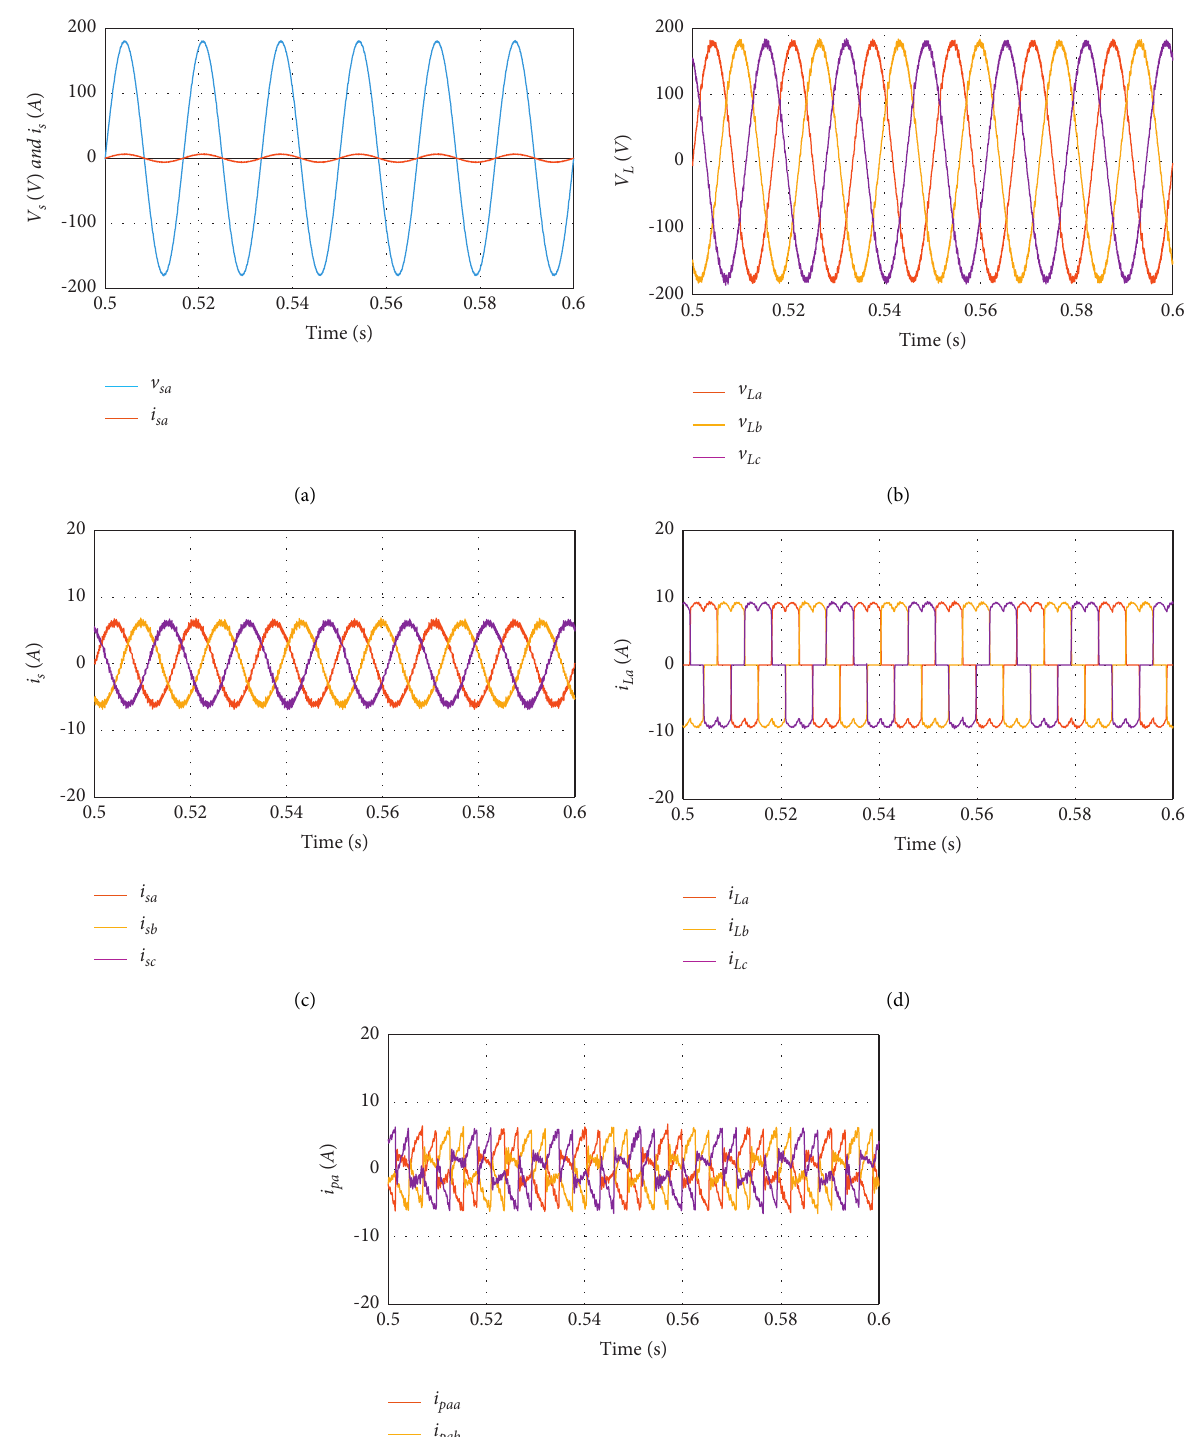
Figure 6: Active filtering along with active power interjection is performed by Wind-PV-UPQC with P current, (b) load voltage, (c) grid currents, (d) load current, (e) parallel converter